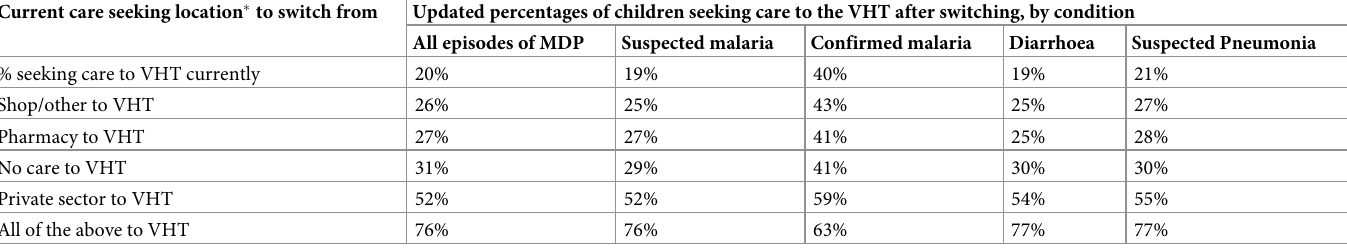
Table 10. Updated percentages of children with suspected malaria, diarrhoea or suspected pneumonia who would seek care to the VHT ( � as the first port of call), if children currently taken to the alternative providers listed on the left were instead taken to their VHT. Current care seeking location � to switch from Updated percentages of children seeking care to the VHT after switching, by condition All episodes of MDP Suspected malaria Confirmed malaria Diarrhoea Suspected Pneumonia % seeking care to VHT